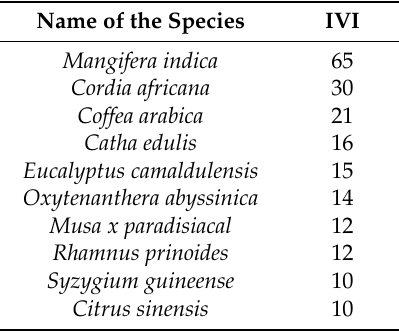
Table 4. Importance value index (IVI) ranking of the top 10 woody and herbaceous perennial species in home gardens of Assosa district, western